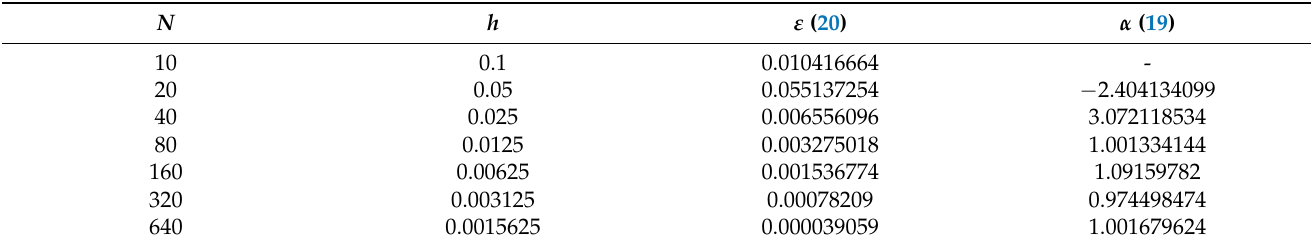
Table 5. Error and computational accuracy of the scheme